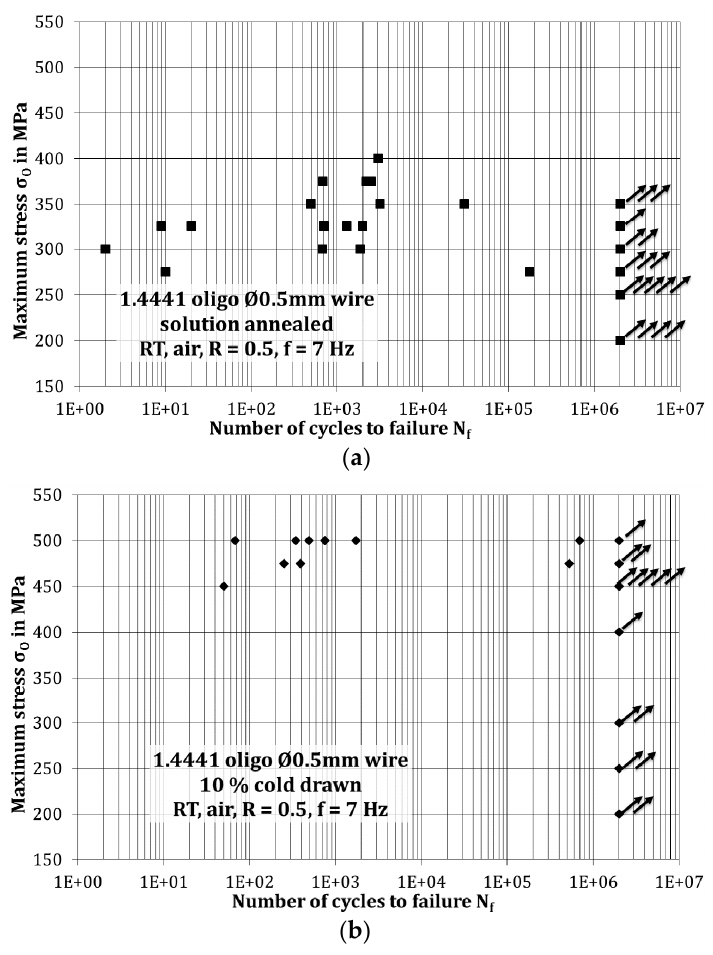
Figure 4. Woehler diagrams of ( a ) solution annealed and ( b ) 10% cold drawn 316LVM wires.